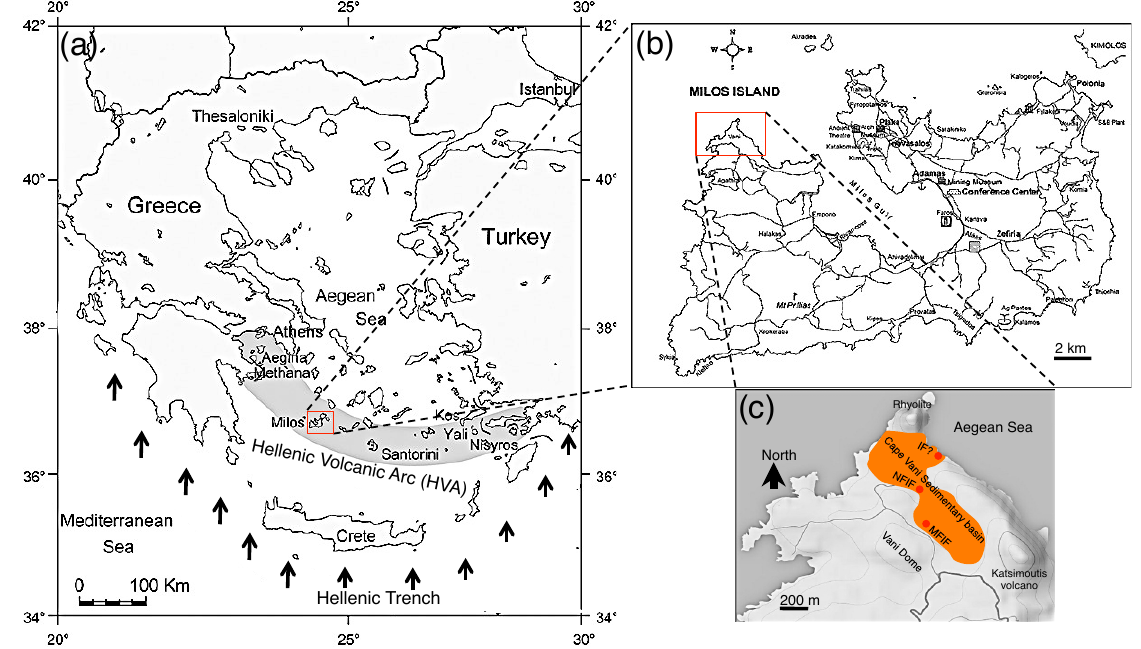
Figure 1. Geological map of Milos (redrawn from Marschik et al., 2010). (a) Geotectonic map showing the position of Milos Island, along the Hellenic Volcanic Arc (HVA). Arrows indicate northeast subduction of the African plate underneath the Eurasian plate. (b) Milos Island. (c) The Milos iron formation is located in the eight-shaped Cape Vani sedimentary basin (CVSB). At least two IFs are present in the CVSB. These are made up of a nonfossiliferous IF (NFIF) at the juncture between the two large sedimentary basins and a microfossiliferous IF (MFIF) located at the SW margin in the second basin. A potential third IF (“IF?” in panel c ) is located to the NE, close to the present-day Aegean Sea. It is, however, not certain if this deposit is part of the NFIF or not because of the open mining pit separating the